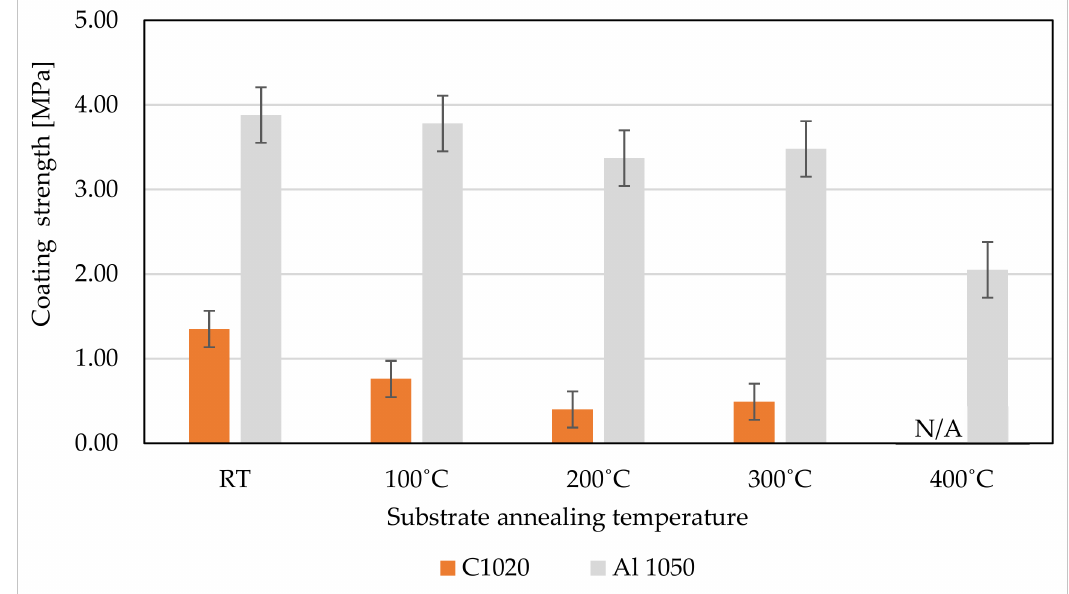
Figure 3. Coating strength of the TiO 2 on C1020 and AA1050 from RT to a 400 ◦ C annealing temperature.